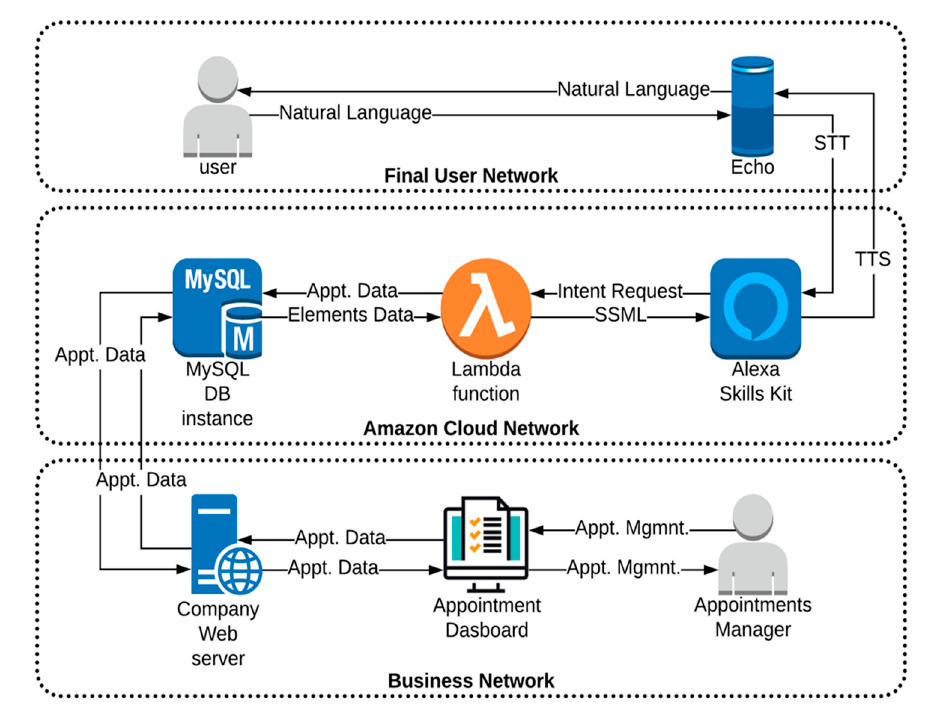
Figure 2. Main components of the prototype skill. TTS: Text-To-Speech, STT: